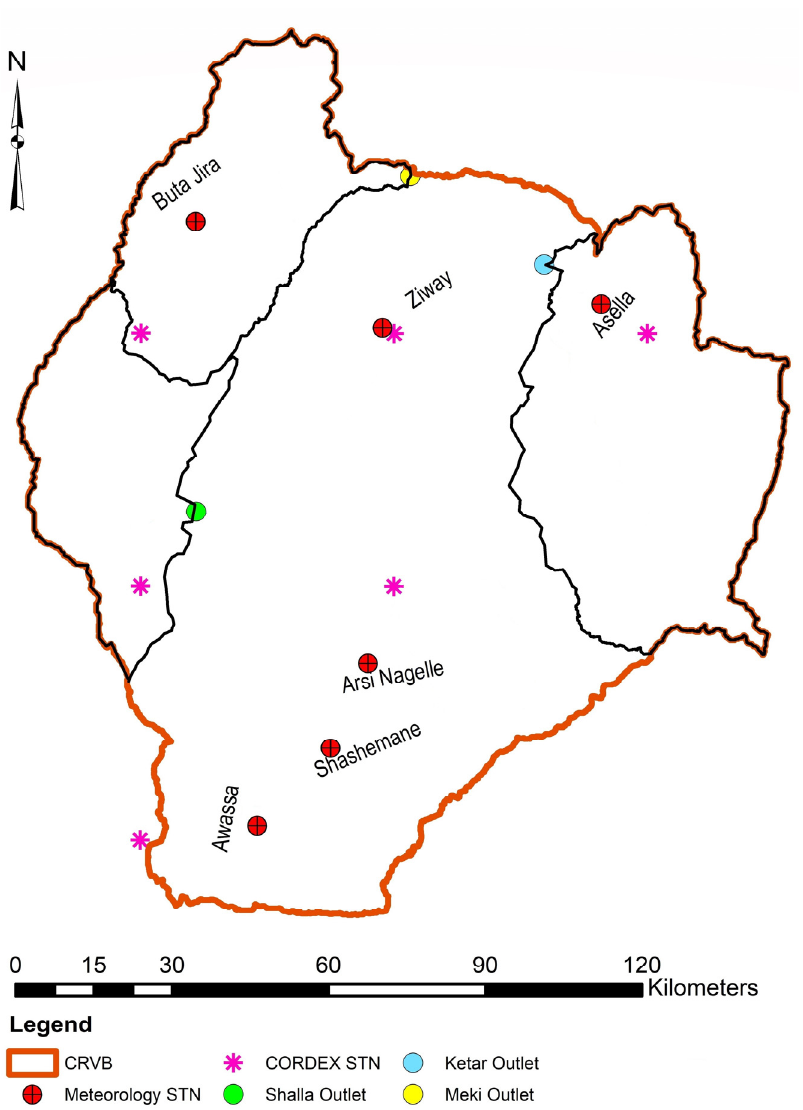
Figure 3. Locations of meteorology stations (Meteorology STN), CORDEX grid point (CORDEX STN), and outlets (Discharge monitoring stations).